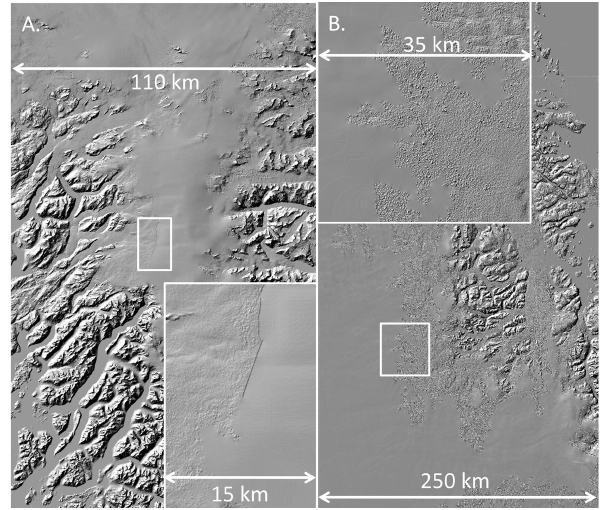
Figure 8. Hillshade representations of examples of common arti- facts in the GIMP DEM. Boxes denote the location of enlarge- ments. (a) Example of an offset in the boundary between the merged GDEM/SPIRIT mosaic and the PEB DEM in a particularly steep section of the ice sheet margin from tile 0,2. The apparent “cliff” re- sulting from this offset is up to 5m high. (b) Example of rough ice sheet surfaces resulting from blunders in stereo-photogrammetric DEM extraction over relatively featureless terrain. The smoother areas are PEB DEM data coverage. The roughness amplitude is less than 3m.